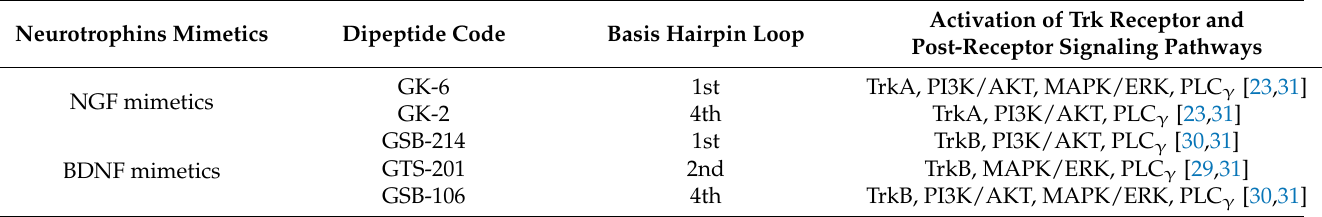
Table 1. Post-receptor signaling pathways activation patterns by NGF and BDNF dipeptide mimetic in in vitro